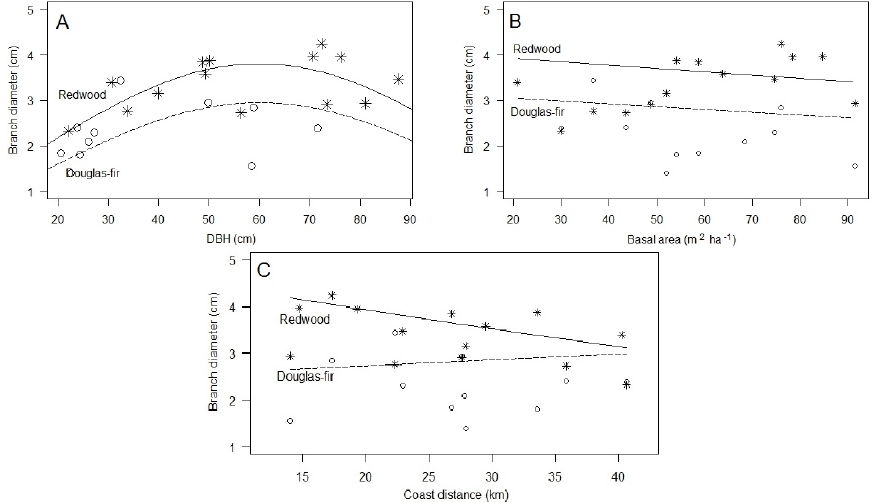
Figure 2. BIX relationship to ( A ) dbh and ( B ) stand density in terms of basal area, and ( C ) the influence of the ecological gradient (distance from the coast), and actual data from the control plots for redwood (*) and Douglas ‐ fir (o) BIX in Mendocino County, California.